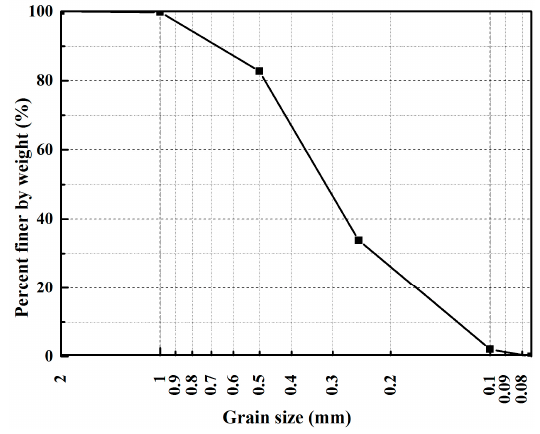
Figure 1. Grain size distribution of sand.